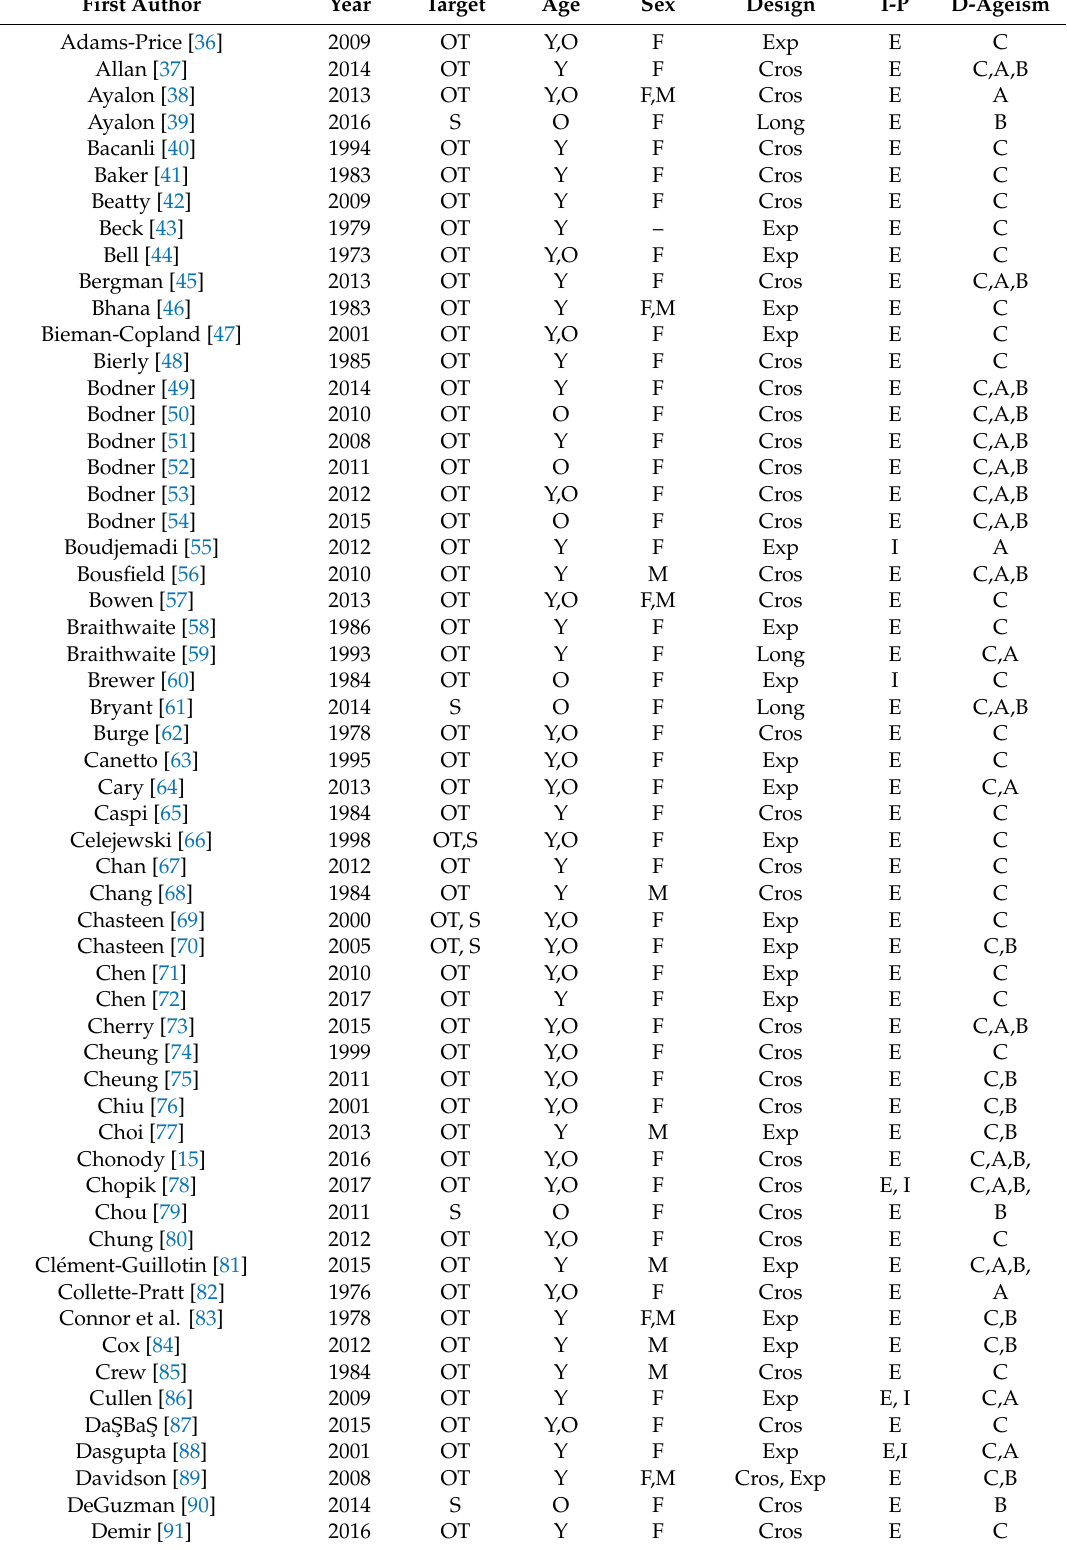
Table 1. Characteristics of the studies included in this